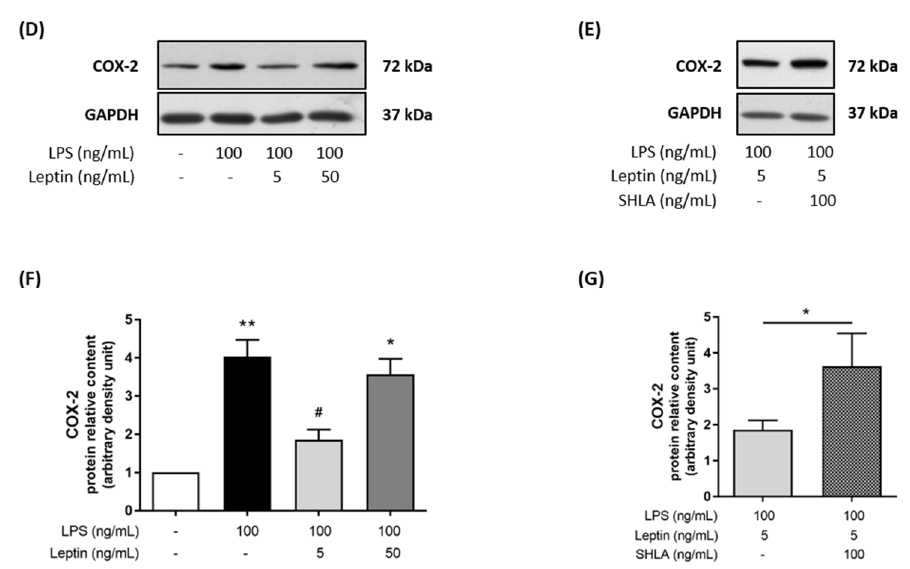
Figure 1. Tocolytic effect of leptin at 5 ng/mL on myocytes/macrophages co-culture in response to an LPS-stimulation. ( A ) Photographs of collagen lattices of co-cultures of myocytes and macrophages with or without of LPS, leptin, SHLA, for 96 h. Images are representative of six independent experiments. ( B , C ) Percentage contraction of collagen lattices (mean ± SEM) after 96 h of stimulation with LPS, leptin and/or SHLA, compared to the initial surface area, n = 6, * p < 0.05 and *** p < 0.001 versus Untreated, ### p < 0.001 versus LPS. ( D , E ) Representative blots of COX-2 and GAPDH proteins stimulated with LPS, leptin and/or SHLA. ( F , G ) COX-2 and GAPDH protein relative content represented as fold induction (mean ± SEM) and expressed in ADU, n = 3–4, * p < 0.05 and ** p < 0.01 versus Untreated, # p < 0.05 versus LPS.